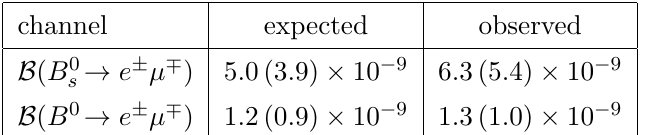
! e (cid:6) (cid:22) (cid:7) ) and B ( B 0 ! s ! e (cid:6) (cid:22) (cid:7) ) is evaluated under the assumption s